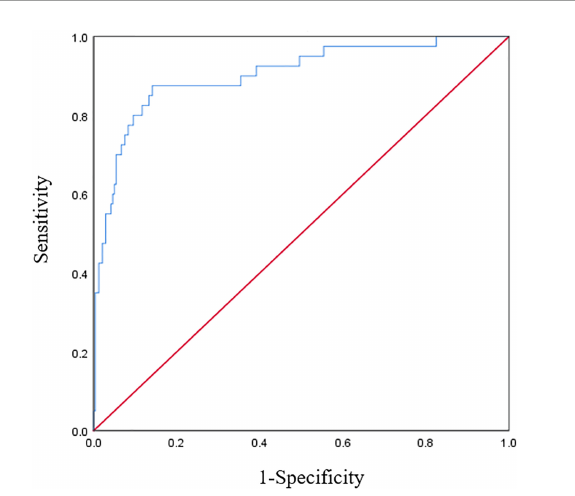
FIGURE5 Receiver operating characteristic (ROC) curve of the intensive care unit acquired weakness (ICU-AW) risk prediction